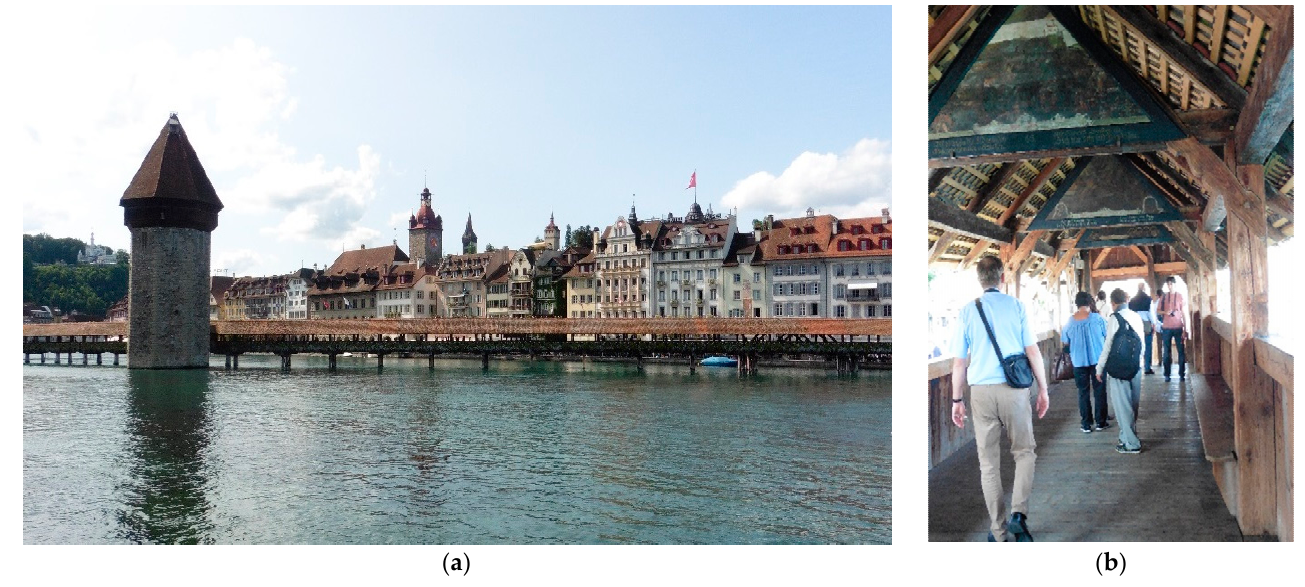
Figure 1. ( a , b ) Kapellbrucke in Lucerne: view and roofing detail; photo: Joanna Arlet. In timber frame structures, the ground beams were: “(…) joined in the corners by a finger lap joint (known also as the Tyrolean lap joint) with a half lap joint with pegs or a French lap joint; - intermediateposts were joined with the ground beam by means of a simple tenon, whereas the corner pillars were joined with side tenons (teased);” (Jasie´nko et al. 2014, p. 6). The timber frame structure required stiffening diagonal elements: braces to support the corners or angle braces connecting the post to the capping or bolt. These elements were usually connected with diagonal tenons or dovetail